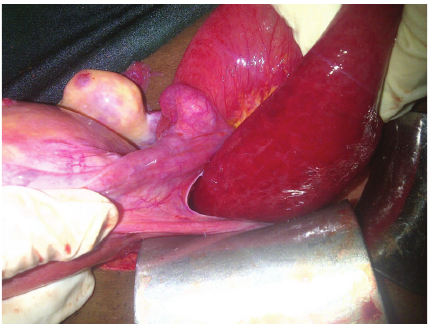
Figure 1: Herniated bowel through the defect in the broad ligament.